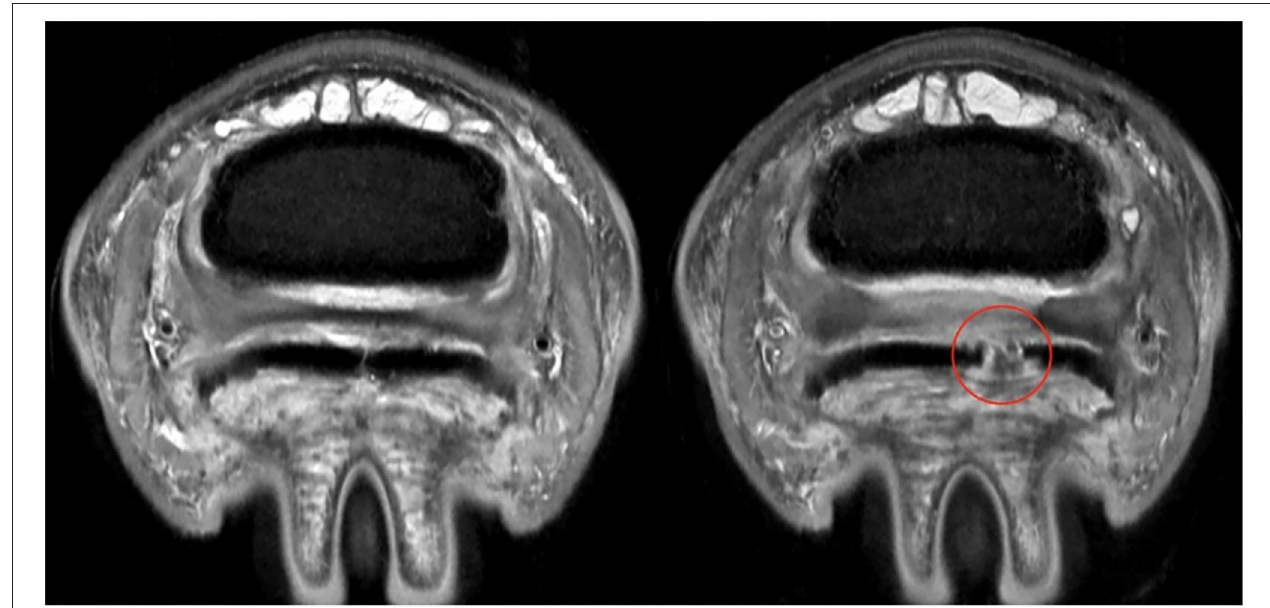
FIGURE 4 | ABNORMAL Deep Digital Flexor Tendon. Axial section at same level of the foot for the same horse at two different time points. (Left) First time point, the delineation of the DDFT can be established. (Right) MRI scan 10 months later, demonstrating a complete and wide parasagittal split (red circle) in the lateral lobe of the DDFT. In this case, the lesion was NOT segmented with the tendon. Only intact portions of tendon were used for segmentation. This provides an absence of data in the DDFT for analysis purposes. The horse also experienced a worsening of clinical signs. Top of the image represents the dorsal aspect of the limb.